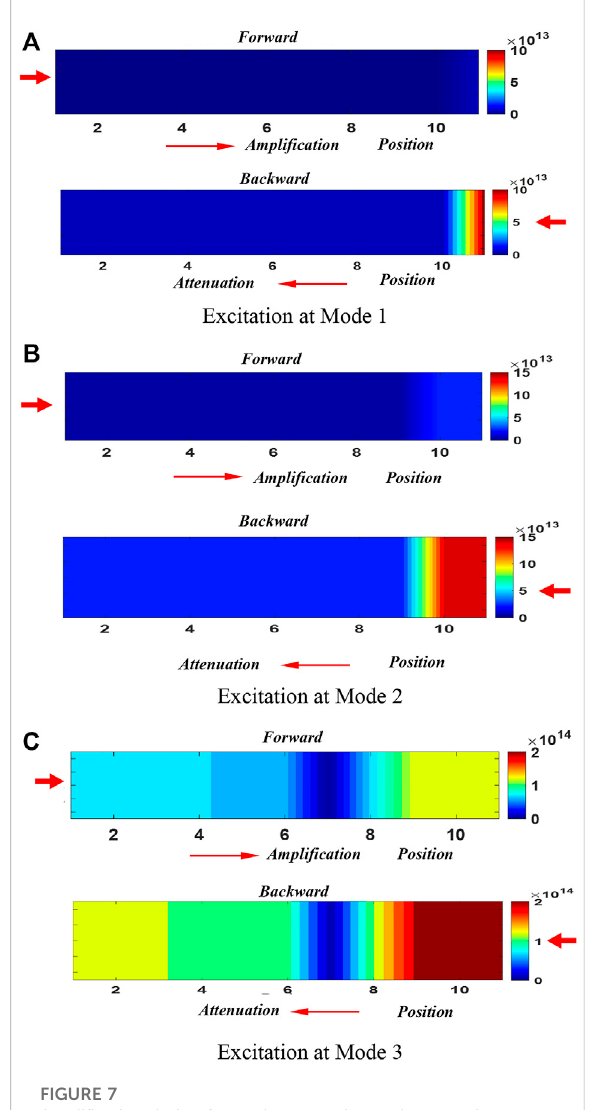
FIGURE 7 Ampli fi cation during forward propagation and attenuation during backward propagation at different excitation